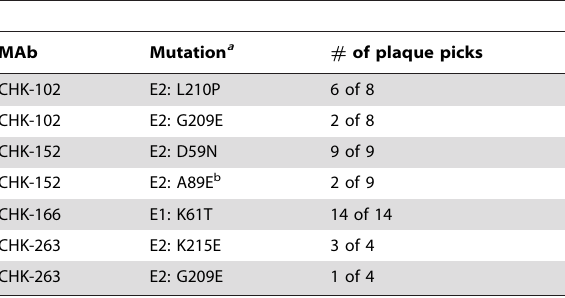
Table 3. In vivo selection of viruses resistant to MAb